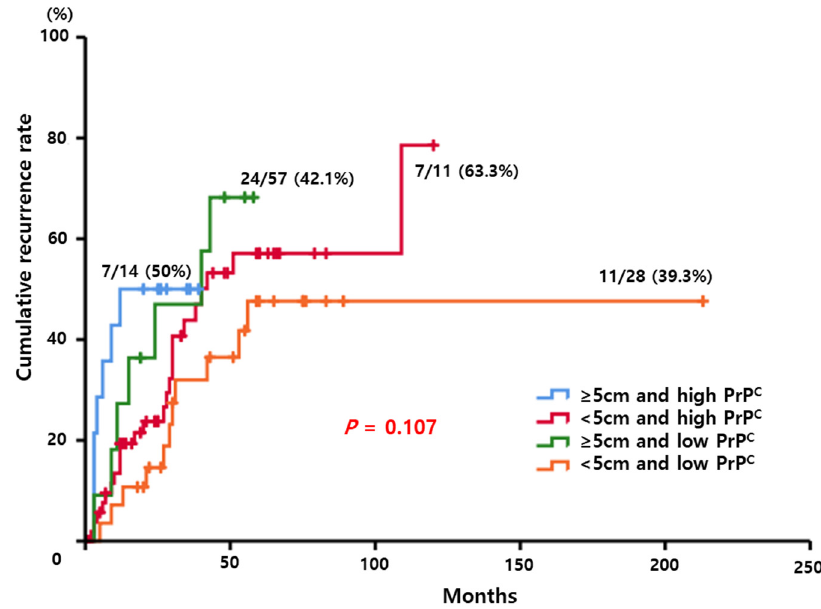
Figure 5. Kaplan–Meier curve to compare the cumulative recurrence rate according to four combi- nations between tumor size and PrP C expression. HCC patients with larger tumor and high PrP C expression had a higher tendency for recurrence ( p = 0.107).